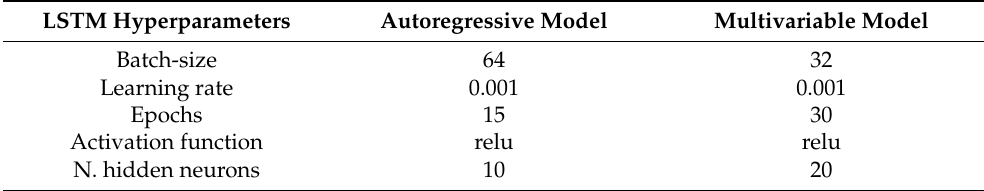
Table 2. Hyperparameters of LSTMs in autoregressive and multivariable approaches. LSTM Hyperparameters